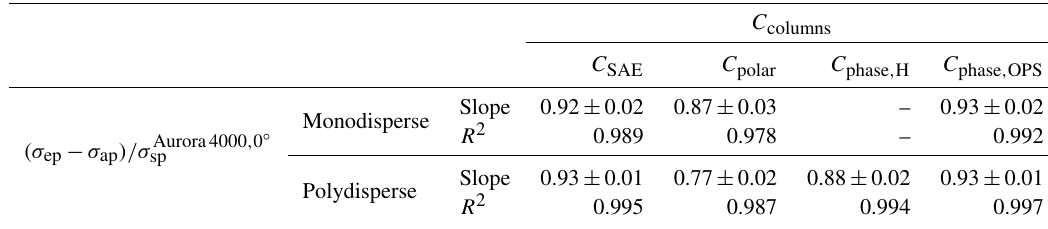
◦ 2 ) of each Table 4. Results of the regression analysis ( C columns = slope (σ ep − σ ap )/σ Aurora4000 , 0 sp and the coefficient of determination R angular correction in the table columns C columns and the ratio between the reference particle scattering coefficient vs. the Aurora 4000 ◦ particle scattering coefficient, (σ ep − σ ap )/σ Aurora4000 , 0 sp